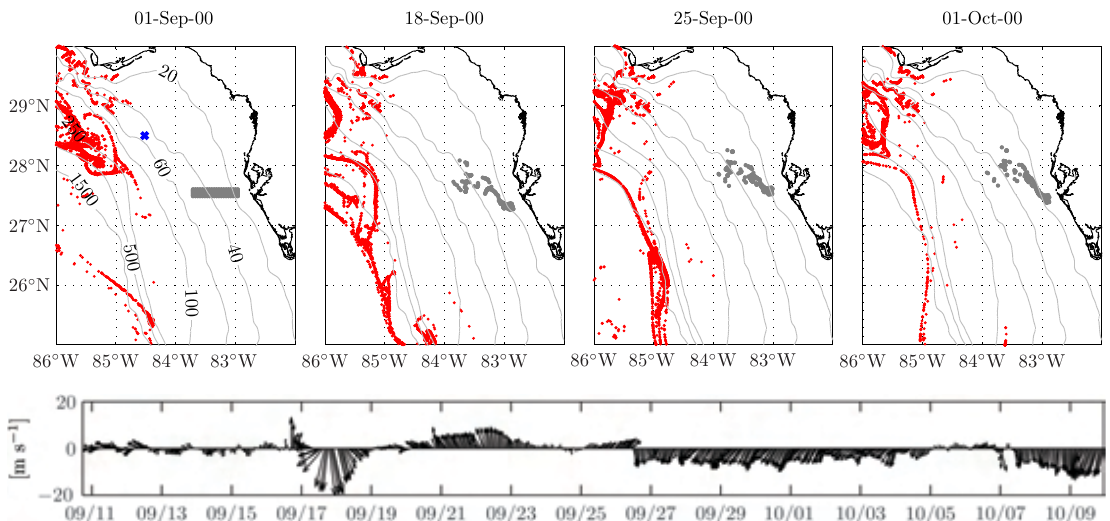
Fig. 8. Top panels: a sequence of snapshots of positions of passive particles released within subsurface layer k = 6. Gray dots correspond to particles released on 1 September 2000 in the inshore side of the CSTB. Red dots correspond to particles released every other day near the Mississippi River mouth. Bathymetry contours shown are in meters. Bottom panel: wind vector time series in the period 11 September 2000 through 10 October 2000 from NOAA meteorological station 42036. The location of this station is indicated with a cross in the upper-left panel.